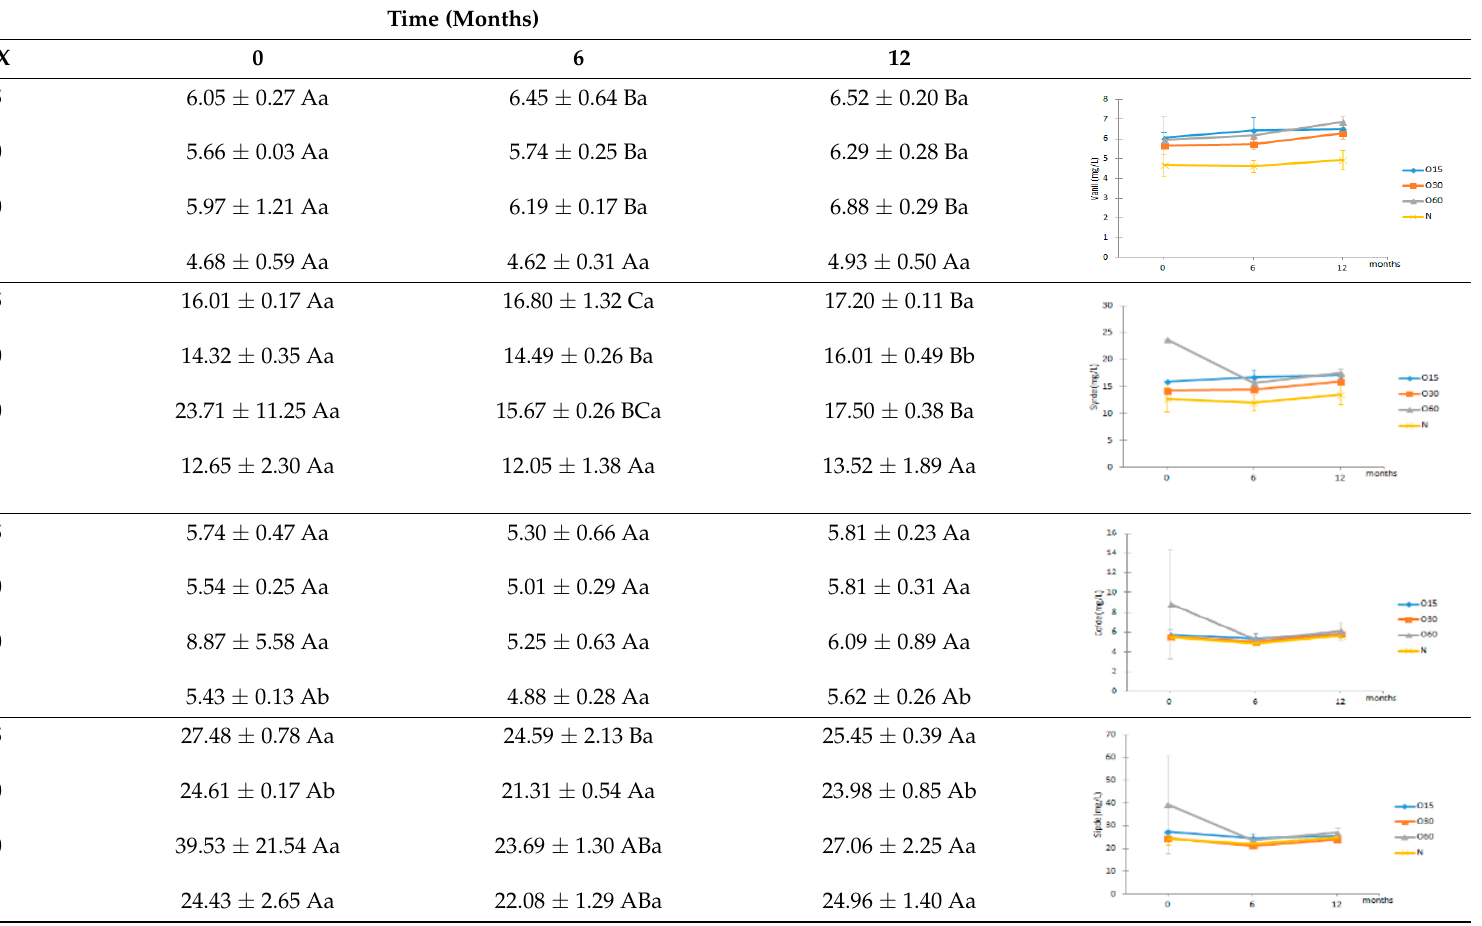
significant differences between ageing modalities in each storage time by Tukey’s test ( p < 0.05); different lowercase letters (a, b) in the same row